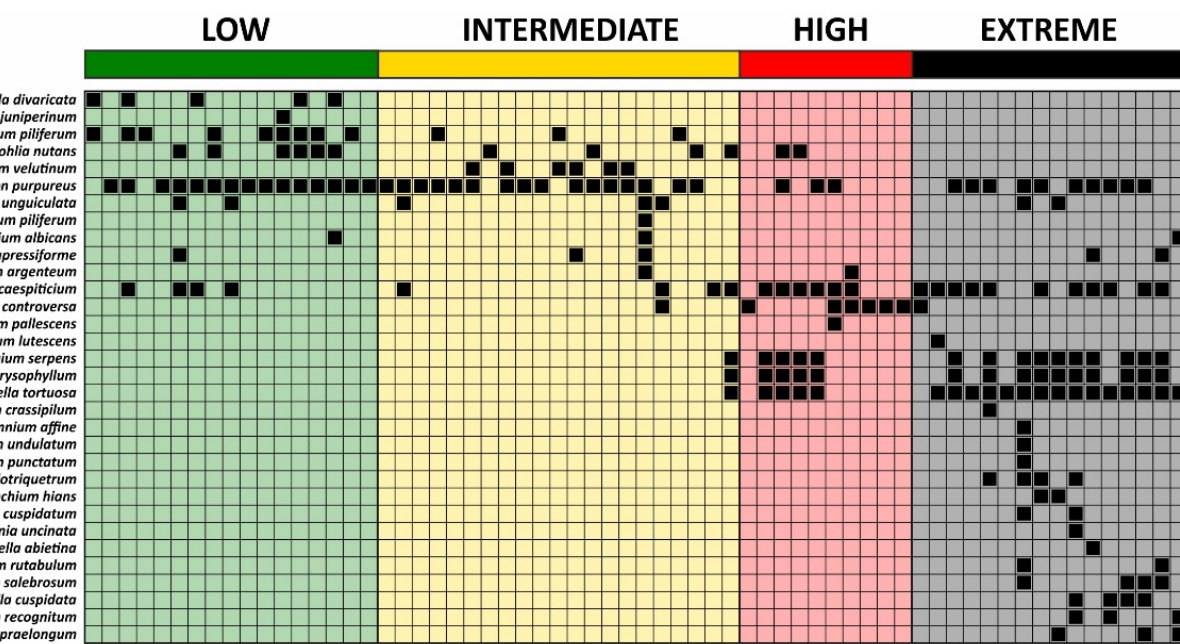
Figure 4. Seriation diagram based on the constrained algorithm of species occurrence in the examined plots arranged according to soil condition classes. For details on soil condition classes, see Figures 1 and 2.